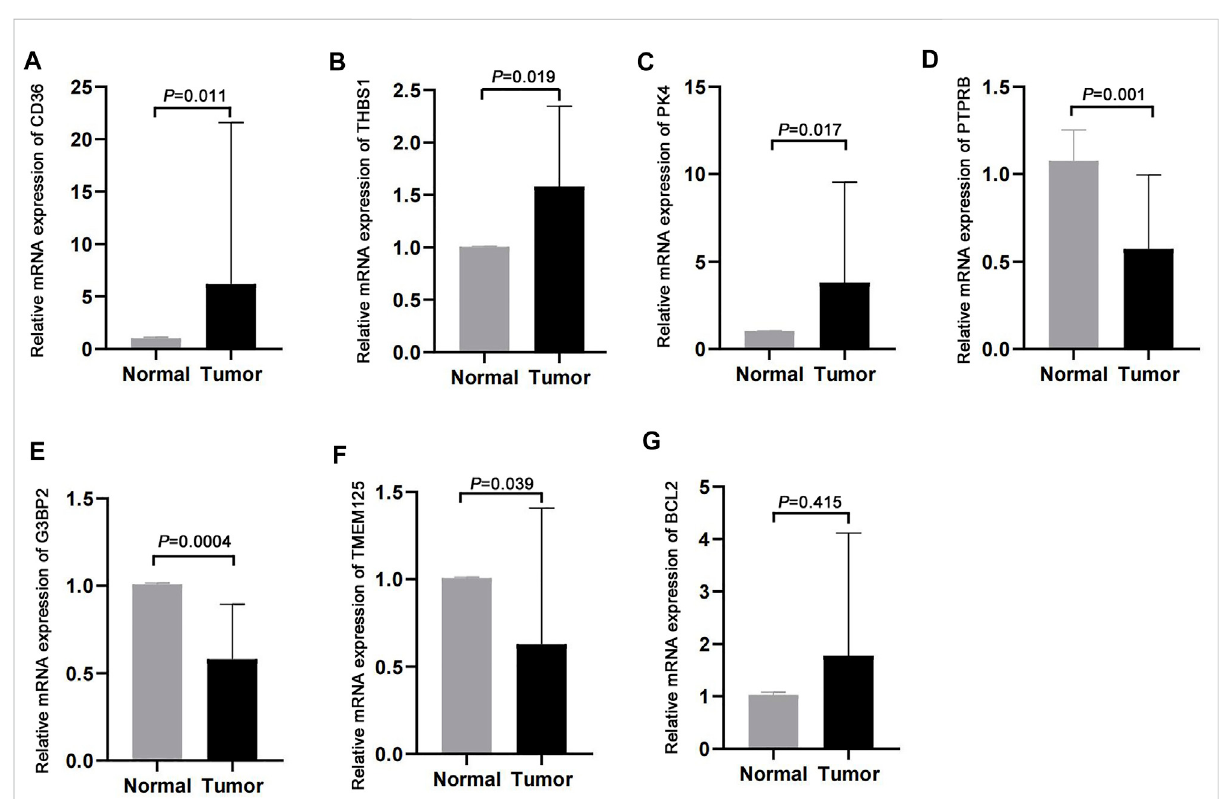
FIGURE 8 Validation in clinical samples. (A – G) Expression of CD36, THBS1, PDK4, PTPRB, G3BP2, TMEM125, and BCL2 in cancer and normal